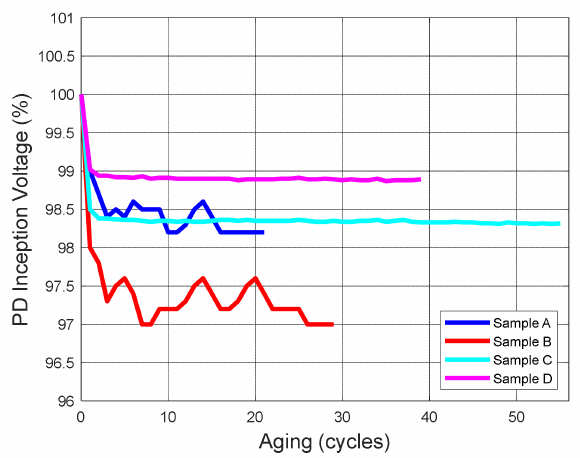
Figure 16. PD inception voltage measurement results at 20.8 kV.